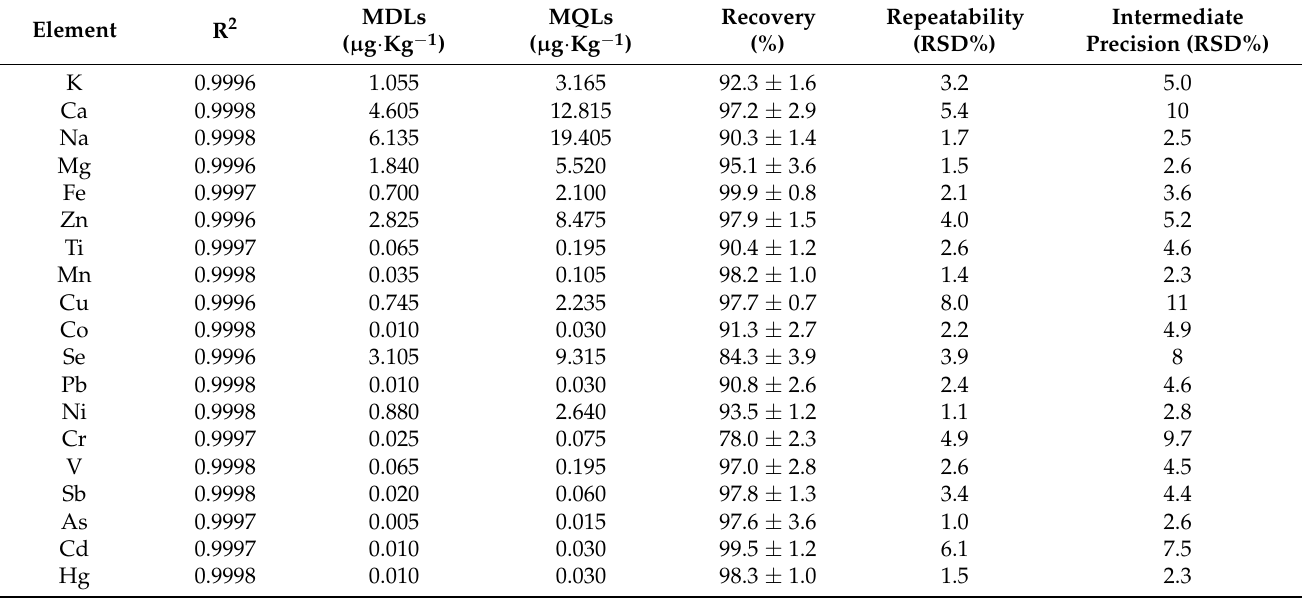
Table 2. Method linearity, method detection limits (MDLs), method quantification limits (MQLs), recovery, repeatability and intermediate